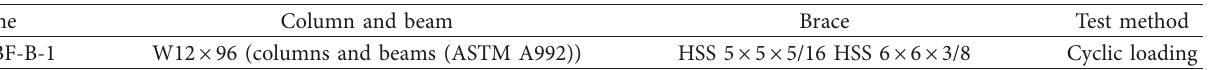
Figure 9: Specimen TCBF-B-1: member sizes [11]. Table 4: Name, member size, material type, and test method of the specimens